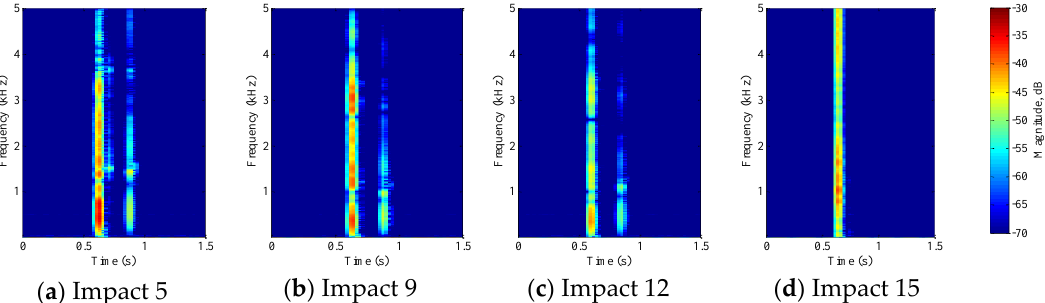
Figure 7 . STFT of PVDF sensor signal for PVA-ECC 2.